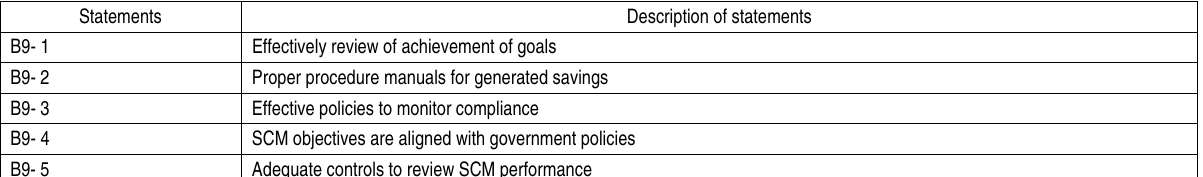
Table 13. Description of statements in Table 12 relating to supply chain